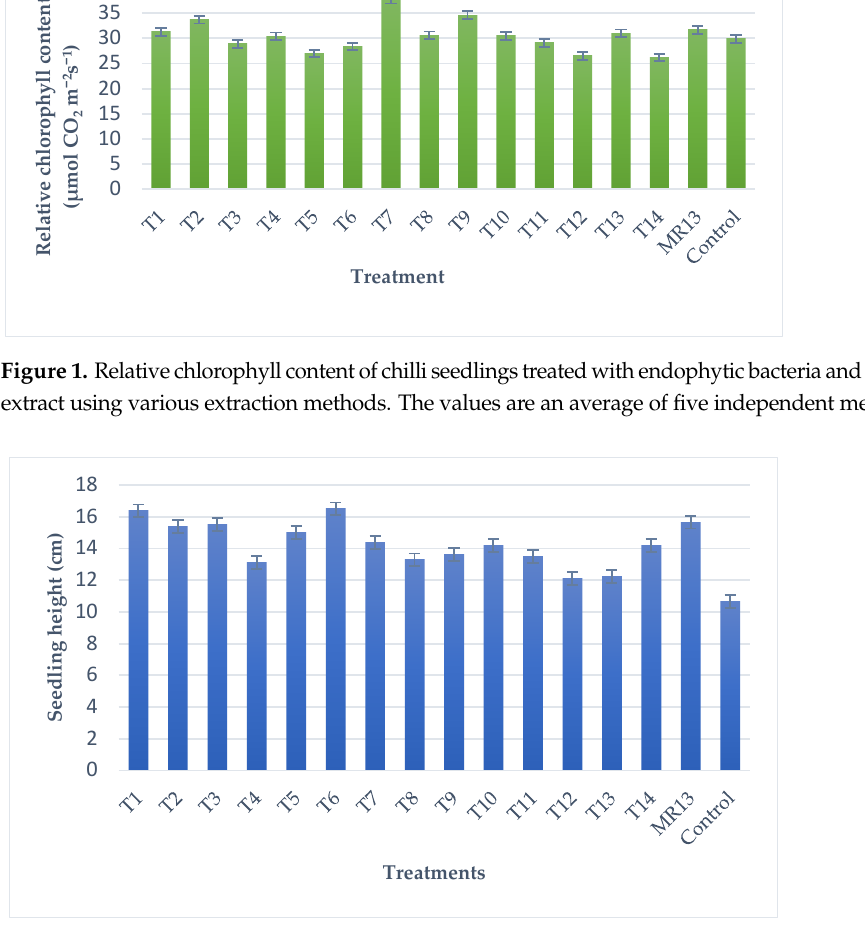
Figure 2. The height of chilli seedlings treated with endophytic bacteria and moringa leaf extract using various extraction methods. The values are an average of five independent measurements.